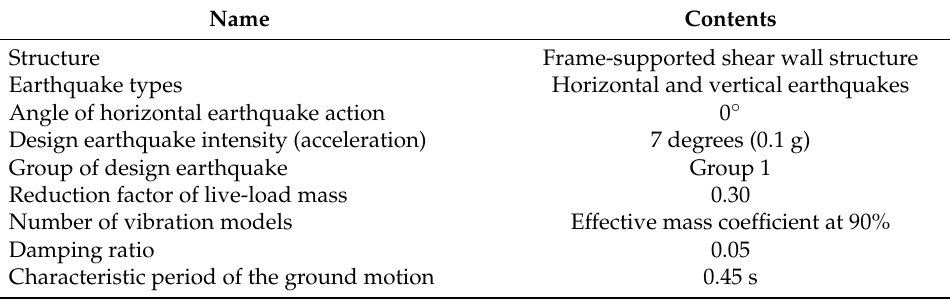
Table 5. Typical parameters of the numerical models.